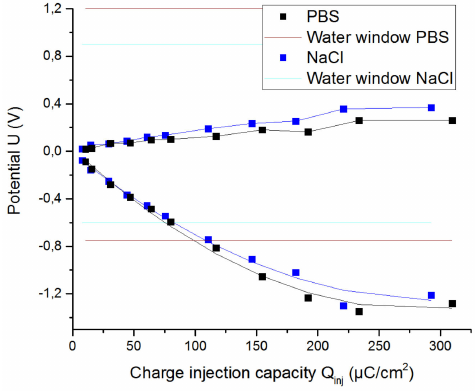
Figure 12. Extreme polarization for the Pt cu ff electrode G in PBS and NaCl solutions, using a stimulation signal of 200 µ